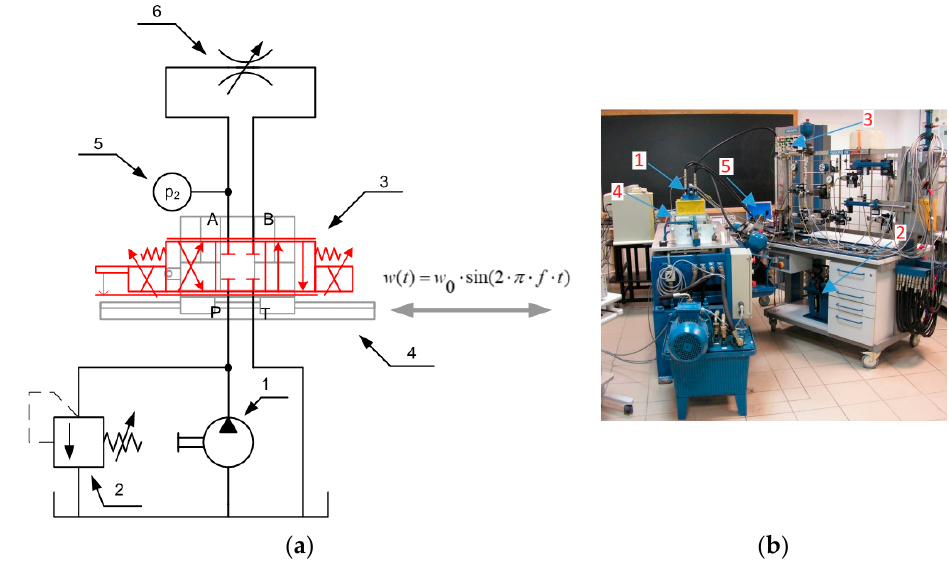
Figure 5. ( a ) Distribution of measurement points in the proportional directional valve test system: 1 – pump supplying the test system of the component under consideration, 2 – relief valve, 3 – Mannesmann-Rexroth 4WRE 6 E08-12/24Z4/M proportional directional valve under test placed